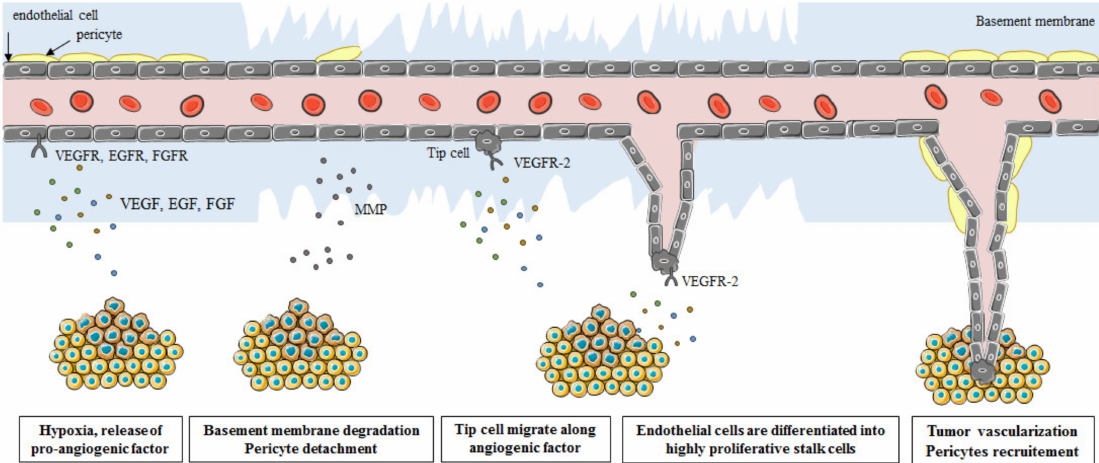
Figure 1. Neoangiogenesis in tumor. A tumor needs nutrients and oxygen (O 2 ) to support neoplastic expansion. The provision of these needs requires the establishment of a new vascular network through the process of angiogenesis. Angiogenesis consists of the assembly of endothelial cells in the form of tubes from existing vessels. During hypoxia and tumor growth, the nuclear translocation of HIF1 α induces the expression of pro-angiogenic factors such as VEGF, EGF, or FGF... Angiogenic factors are able to activate and stimulate endothelial cells through membrane receptors. Indeed, these signals participate in the proliferation, invasion, migration, survival, and increase in the permeability of the vessels. Inspired from the Cancer Research Product Guide Edition 3,